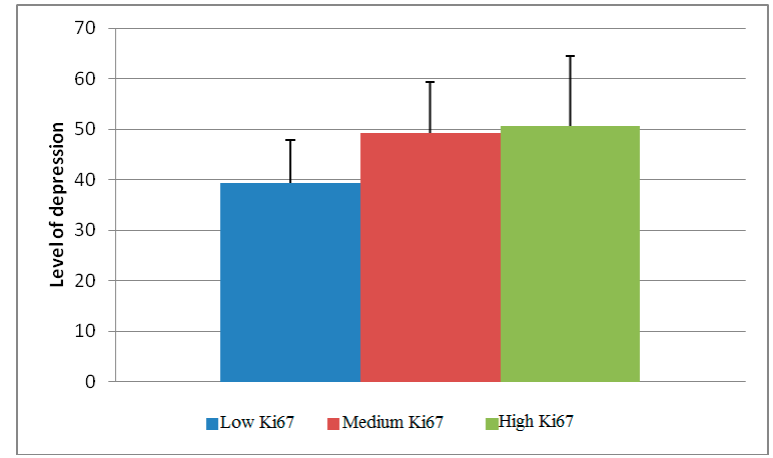
Figure 4. The difference between the mean values of the level of depression between the Ki67 categories.